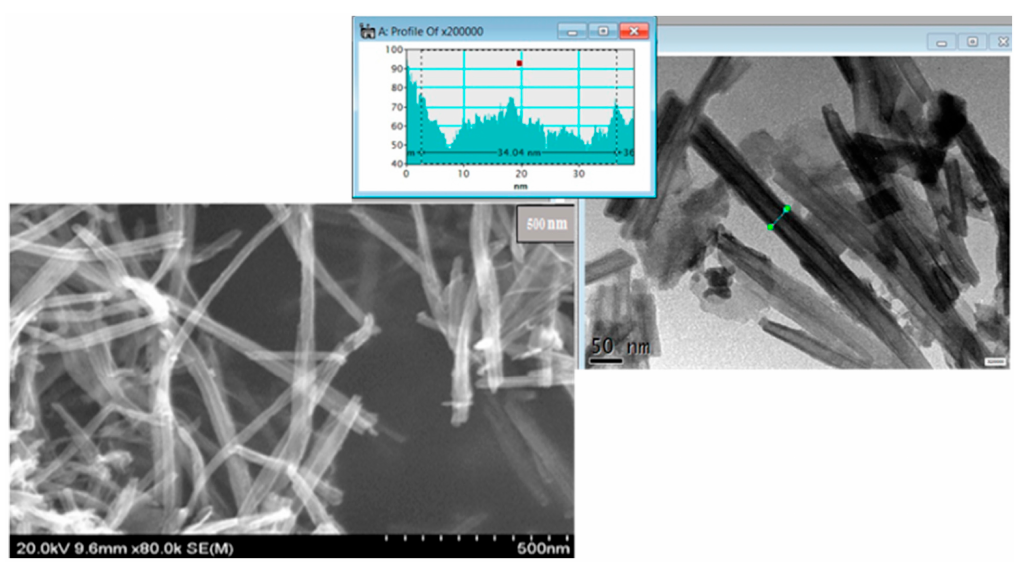
Figure 2. STEM (Dark Field and Bright Field) images of nanotube structures of H 4 Nb 6 O 17 , one can observed a homogeneous dispersion of nanotubes, profile of nanotube width is presented also.